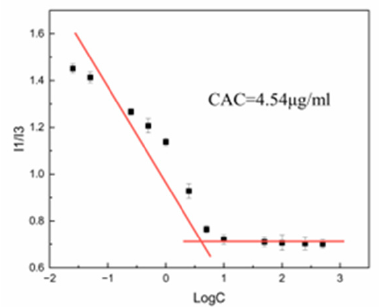
Figure 3. Determination of critical aggregation concentration (CAC) of TH using pyrene fluores- cence method.